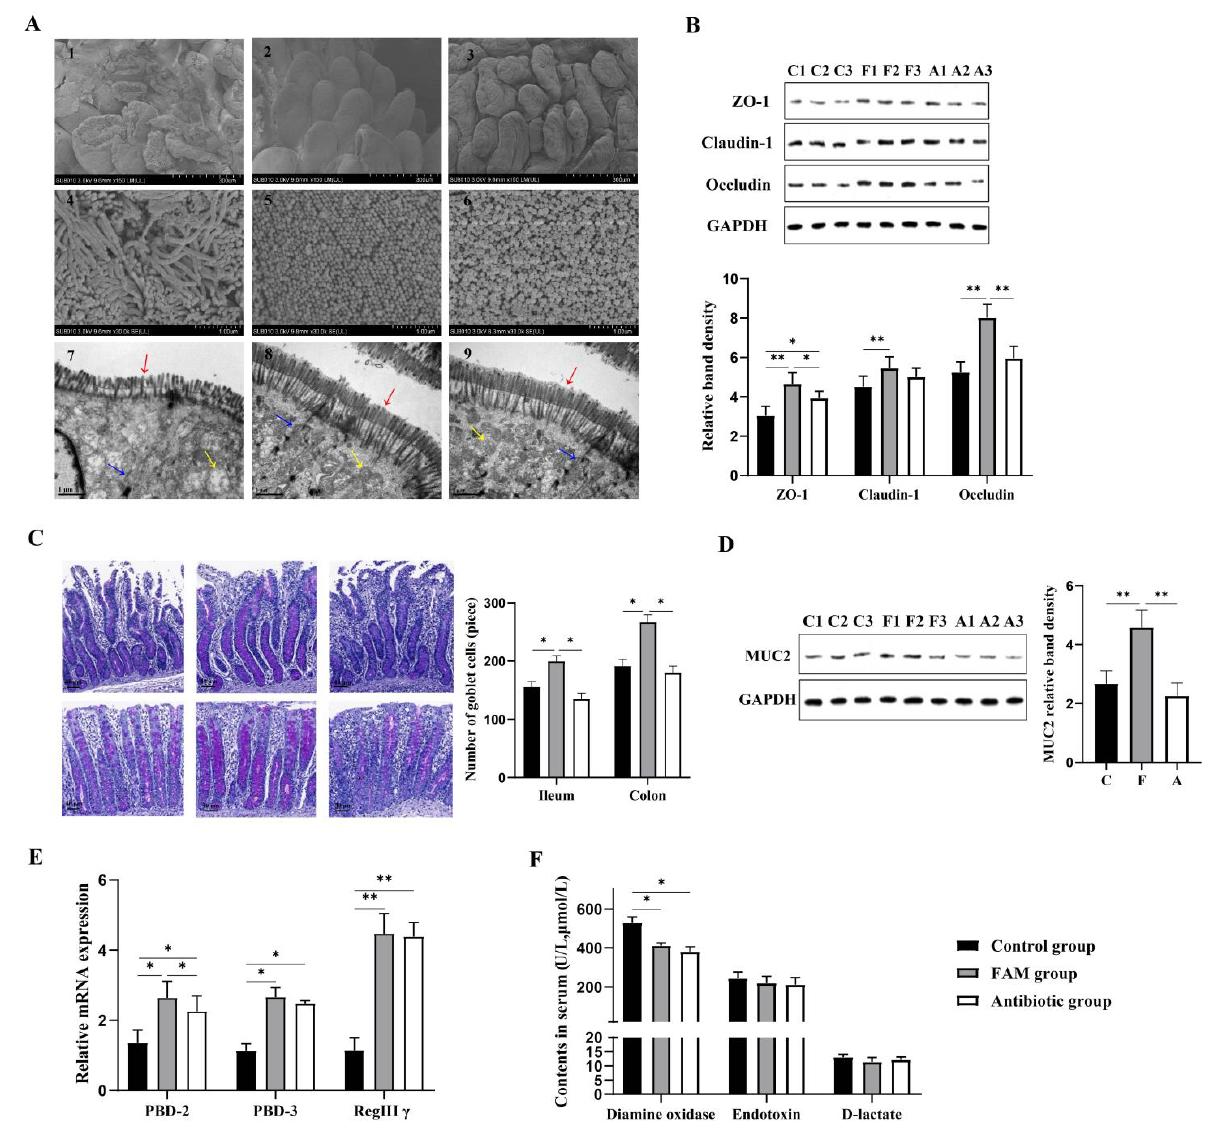
Figure 1. The intestinal barrier homeostasis in piglets. ( A ) Representative electron microscopy images of cross-sections in the piglet jejunum. From top to bottom: 1 – 3 Scanning electron microscopy images of villi morphology, scale bars = 300 µm; 4 – 6 SEM images of microvilli morphology, Scale bars = 100 µm; 7 – 9 Transmission electron microscope images of microvillous structure, including microvilli morphology: red, epithelial cell junctions: blue, mitochondria: yellow, Scale bars = 1 µm. ( B ) Up, relative expression of tight junction protein ZO-1, Claudin-1 and Occludin determined by WB assay. Down, quantitative analysis of tight junction protein levels. ( C ) Left, PAS-stained images of goblet cells in ileum and colon. Right, quantitative analysis of goblets cells. Scale bars = 40 µ m. ( D ) Left, WB assay of MUC2 in the ileum. Right, quantitative analysis of MUC2 protein expression. ( E ) qPCR was performed to detect relative mRNA expression of innate immune factors PBD-2, PBD-3 and RegIII γ . ( F ) Contents of serum DAO, endotoxin and D-lactate measured by ELISA assay ( n = 8). ** p < 0.01, * p <